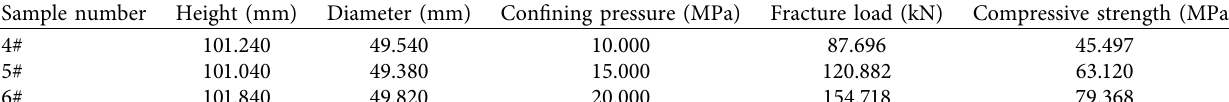
Table 3: Different confining pressure unloading test results.